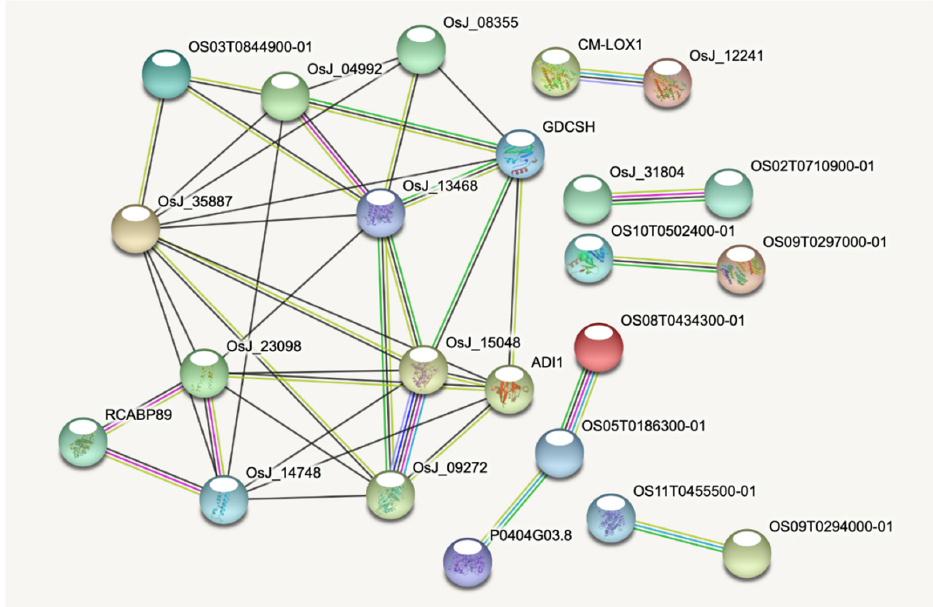
Figure 3. Protein–protein interaction (PPI) network using the 69 rice proteins. Only proteins involved in interactions with a high confidence (combined score higher than 0.7) were shown. For each shown protein, the related rice gene ID is indicated in parentheses: OS03T0844900-01 (Os03g0844900); OsJ_04992 (Os02g0101500); OsJ_08355 (Os02g0744000); OsJ_35887 (Os12g0420200); OsJ_13468 (Os04g0234600); GDCSH (Os10g0516100); OsJ_23098 (Os07g0148900); OsJ_15048